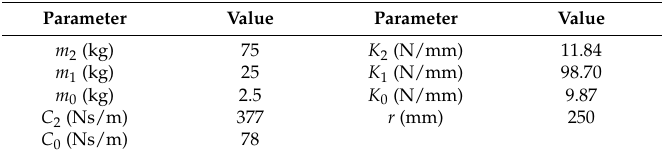
Table 4. The values of the parameters for the human-wheelchair